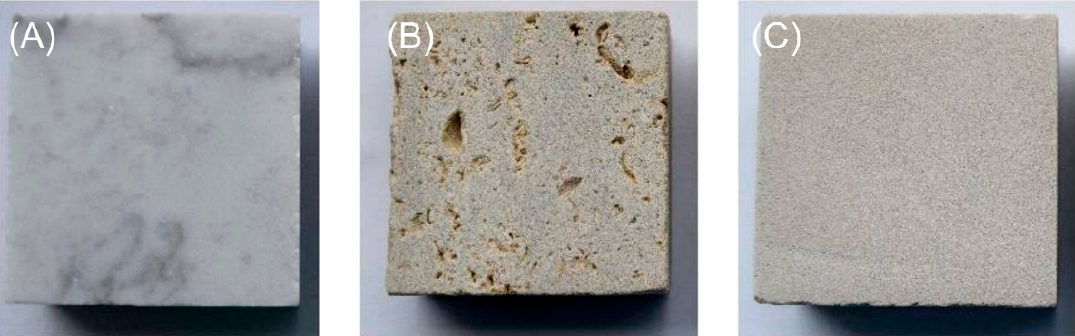
Figure 1. Photographs of Apuan marble ( A ) Balegem limestone ( B ) and Obernkirchen sandstone ( C ) prism specimens (5 × 5 × 2 cm).